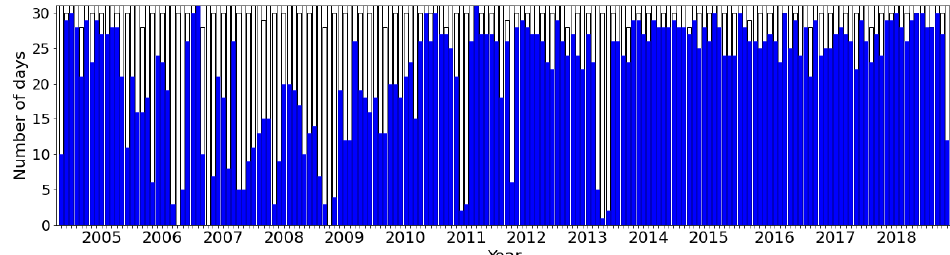
Figure 1. The number of radiosonde measurements in each month that passed the quality control and were used for neural network training, validation and testing; shown with blue bars. Grey bars indicate number of days in each